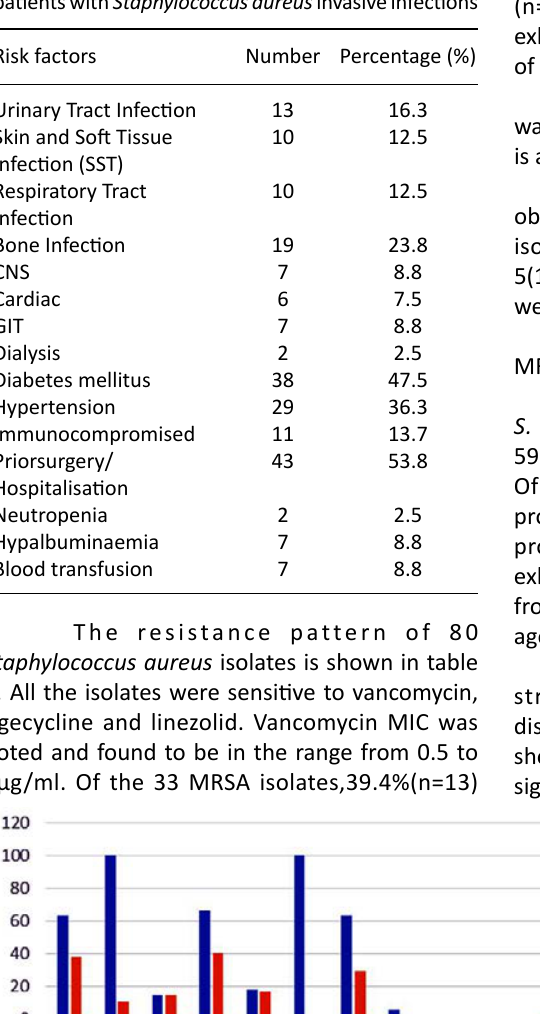
Table 3. Risk factors and Co-morbidities observed in patients with Staphylococcus aureus invasive infections